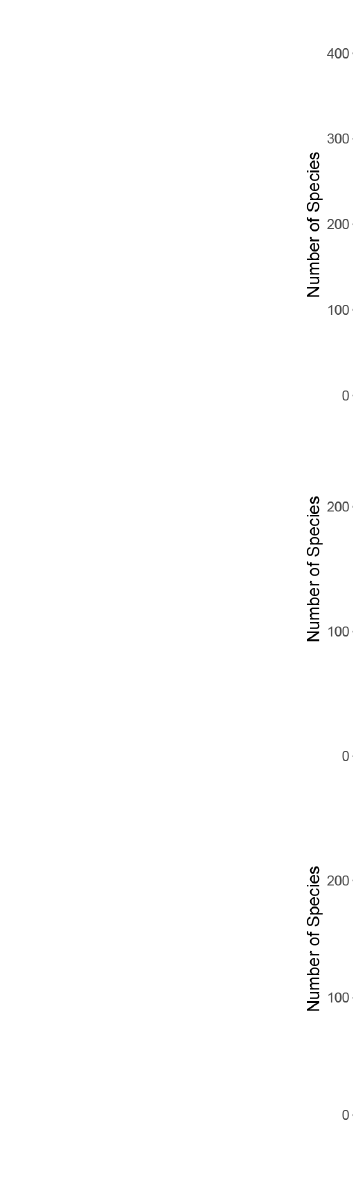
FIGURE 4 Sample-size-based rarefaction (solid line) and extrapolation (dashed line) curves. (A) Rarefaction-and-extrapolation curve of the number of sequenced specimens (x-axis) versus CCRA species richness (y-axis) for the whole of Guam. The grey dot indicates the total number of specimens sequenced and the overall species richness. (B) Rarefaction-and-extrapolation curve of the number of sequenced specimens (x-axis) versus CCRA species richness (y-axis) for the east and west coast of Guam. The red and green dots indicate the total number of specimens sequenced and the species richness for the east and west coast, respectively. (C) Rarefaction-and-extrapolation curve of the number of sequenced specimens (x-axis) versus CCRA species richness (y-axis) of the Corallinophycidae and Peyssonneliales. The red and green dots indicate the total number of specimens sequenced and the species richness of the Corallinophycidae and Peyssonneliales,